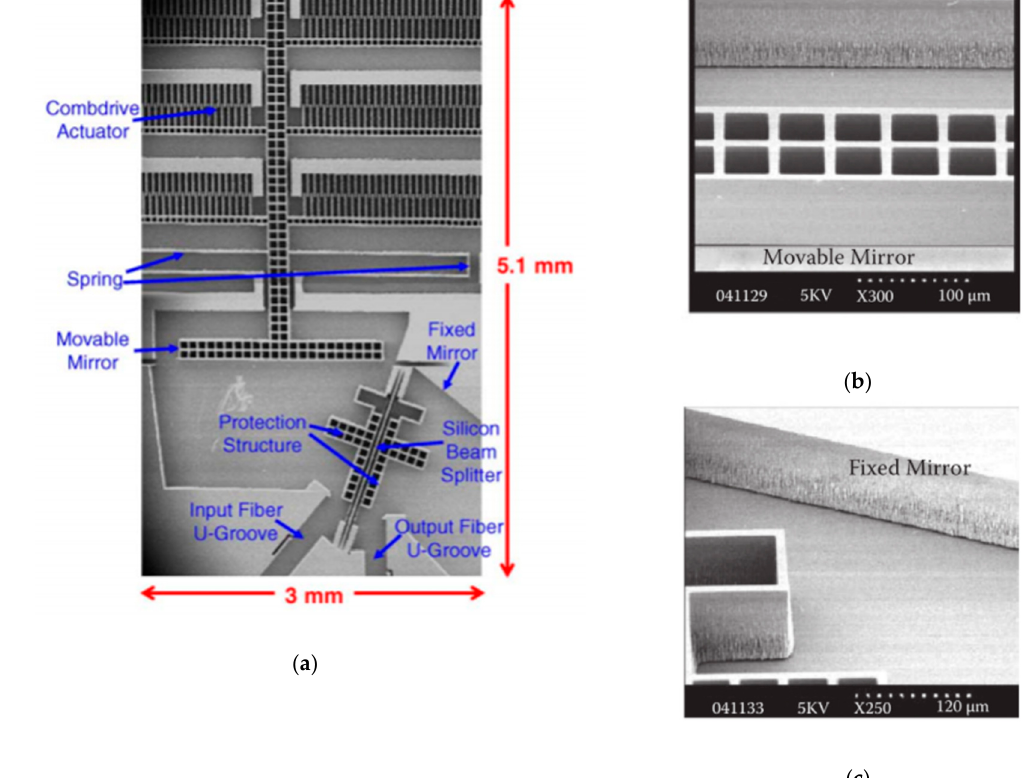
Figure 8. An in-plane electrostatic comb-based FTS: ( a ) SEM of the micromachined FTS; ( b ) SEM of the movable micromirror with the sidewall obtained by potassium hydroxide (KOH) etching; ( c ) SEM of the fixed mirror with the sidewall defined by deep reactive ion etching (DRIE). (Reprinted with permission from Reference [31] Elsevier).